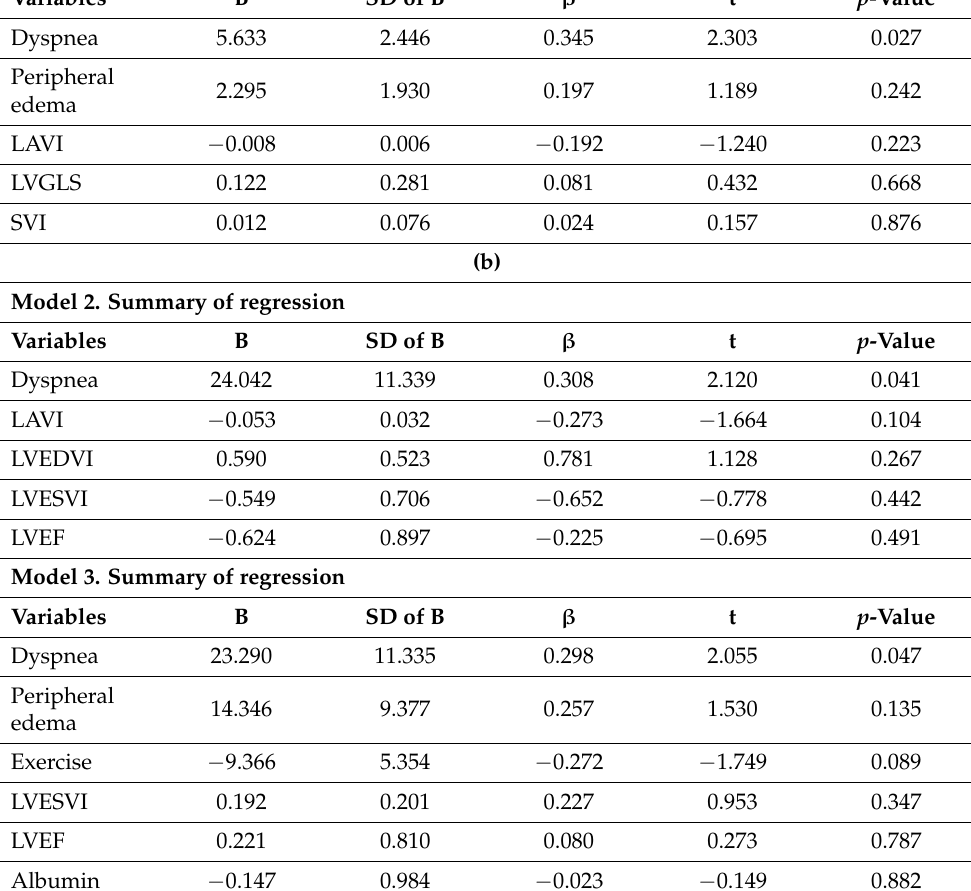
Model 1. Summary of